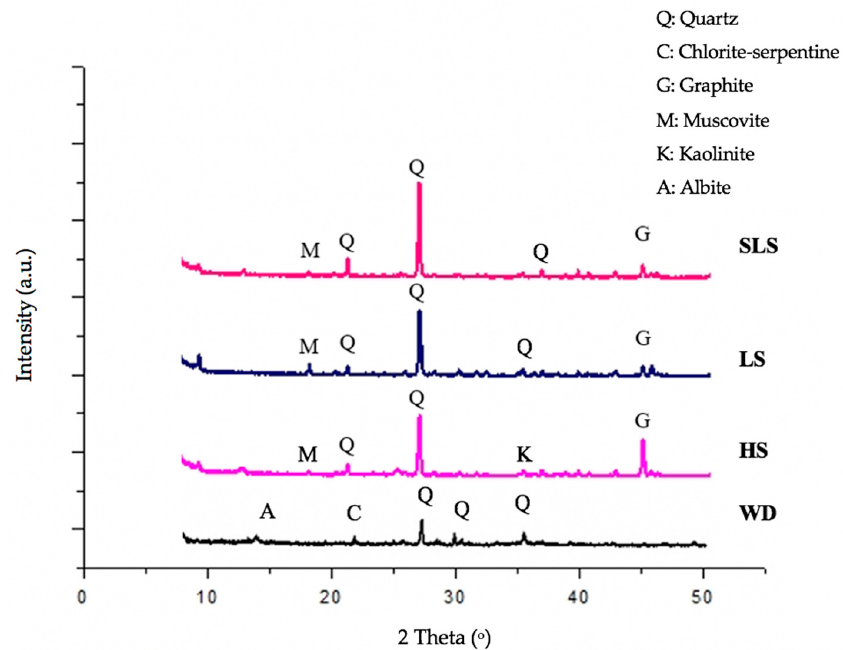
Figure 2. X-ray diffractograms of waste rocks in waste dump and stockpiles. On the other hand, the soil samples (of waste dump and stockpiles) consisted mainly of illite, (K,H 3 O)(Al,Mg,Fe) 2 (Si,Al) 4 O 10 [(OH) 2 ,(H 2 O) and kaolinite, with a moderate amount of aerinite, ((Fe +2 ,Fe +3 ,Al)3Mg 3 (Ca,Na) 4 (Si 13 . 5 Al 4 . 5 O 42 )(OH) 6 ]· 11 . 3 H 2 O), and a minor amount of stilpnomelane, Fe 2 (Si 3 O 9 ) and polylithionite, K(AlFeLi)(Si 3 Al)O 10 (OH)F miner- als. Specifically, kaolinite and illite were present in all the soil samples. Aerinite was only present in the soil sample of the waste dump, while polylithionite was only present in the stockpile (SLS) and stilpnomelane was only found in the stockpile (LS) sample. The sedi- ment and sludge were composed of the same types of minerals, where illite was the major mineral, followed by chlorite-serpentine and quartz. The XRD patterns of the soil samples are illustrated in Figure 3a, and the sludge and sediment samples are demonstrated in Figure 3b. The presence of the same minerals in the different samples indicated that they were originally derived from the same set of host rock and ore [54].